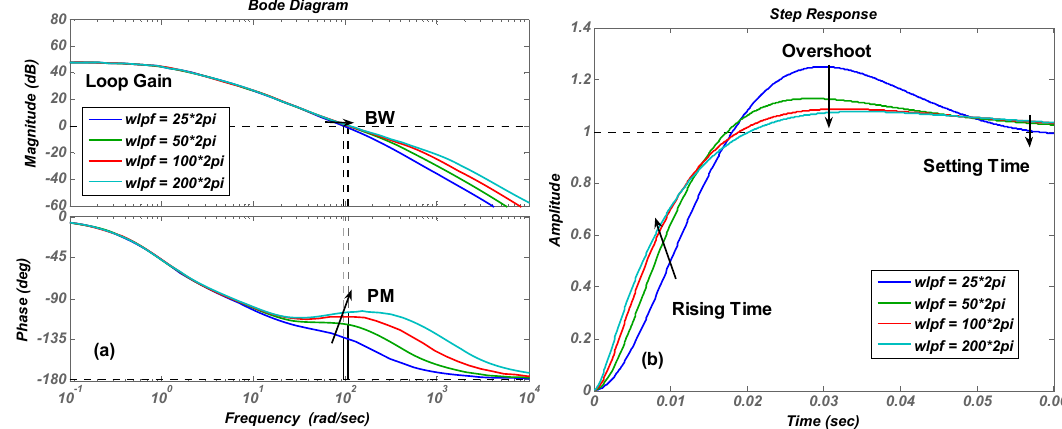
Figure 5. ( a ) Bode diagrams of the control loop ( b ) step responses of the linear model ( c ) and step responses of nonlinear model varying with the cut-off frequency ω